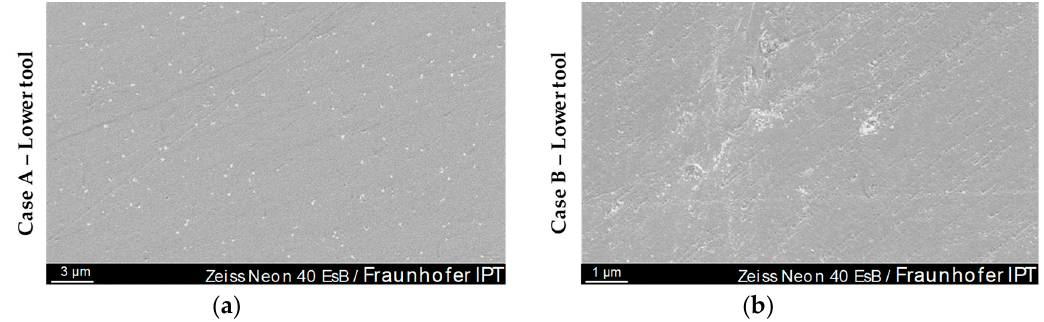
Figure 20. Alterations of the Glassy Carbon tool surface of 30 moulding cycles analysed by SEM: ( a ) Case A—lower tool; ( b ) Case B—lower tool.